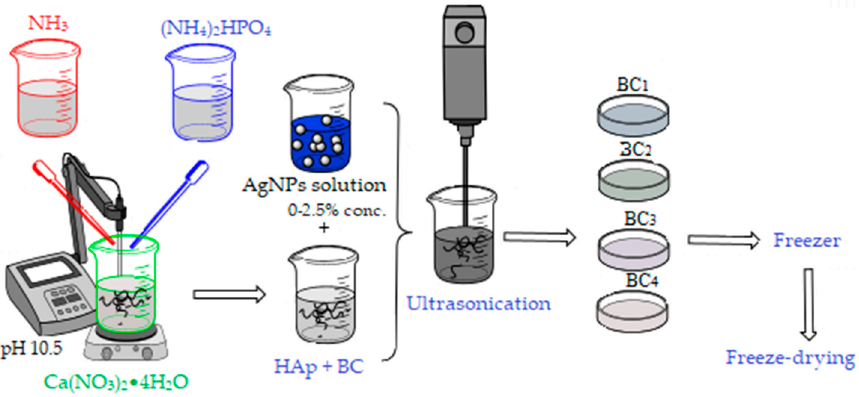
Figure 2. Synthesis of BC 1 , BC 2 , BC 3 , and BC 4 composites; BC, bacterial cellulose. Table 1. Bacterial cellulose, HAp, and AgNP content in the final composites.